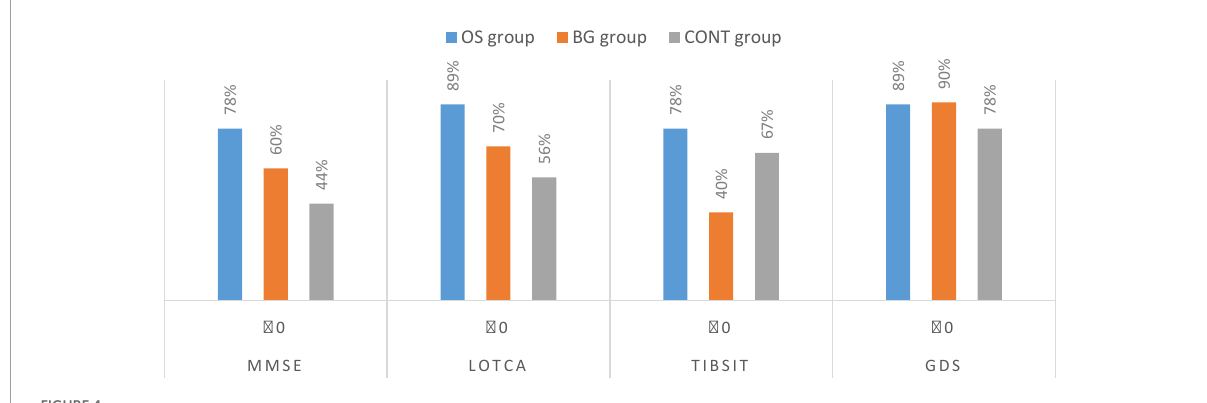
FIGURE4 Shares of participants with stable or improved ( ≥ 0) cognition, olfactory and emotion.